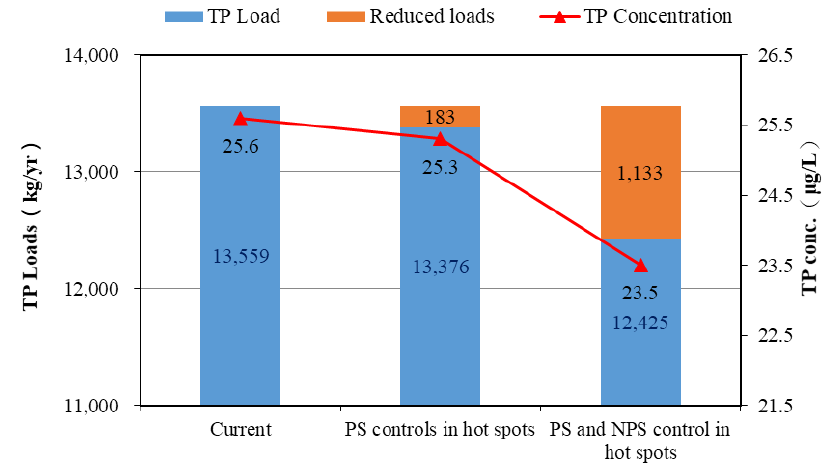
Figure 10. The TP control measures and associated predicted water quality in the Liyutan